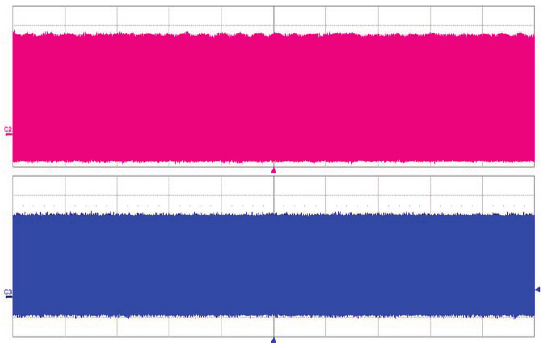
Figure 13. Oscillogram of the signal OPO radiation at 1.53 µ m (upper trace) and 1.06 µ m pump (lower trace)—long-time stability, factor of multiplication n = 13. Time scale 5 µ s/div.